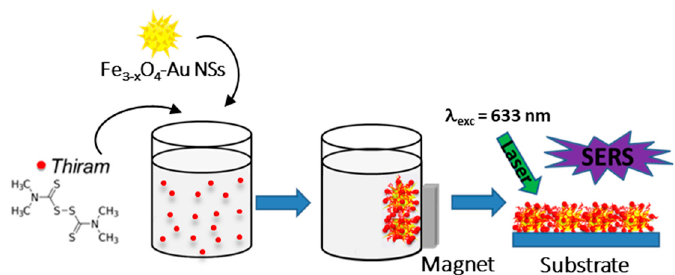
Figure 5. Concentration of the analytes on the star-shapped Fe 3-x O 4 -Au core-shell nanoparticles (NSs) before their collection by a magnet for SERS detection.